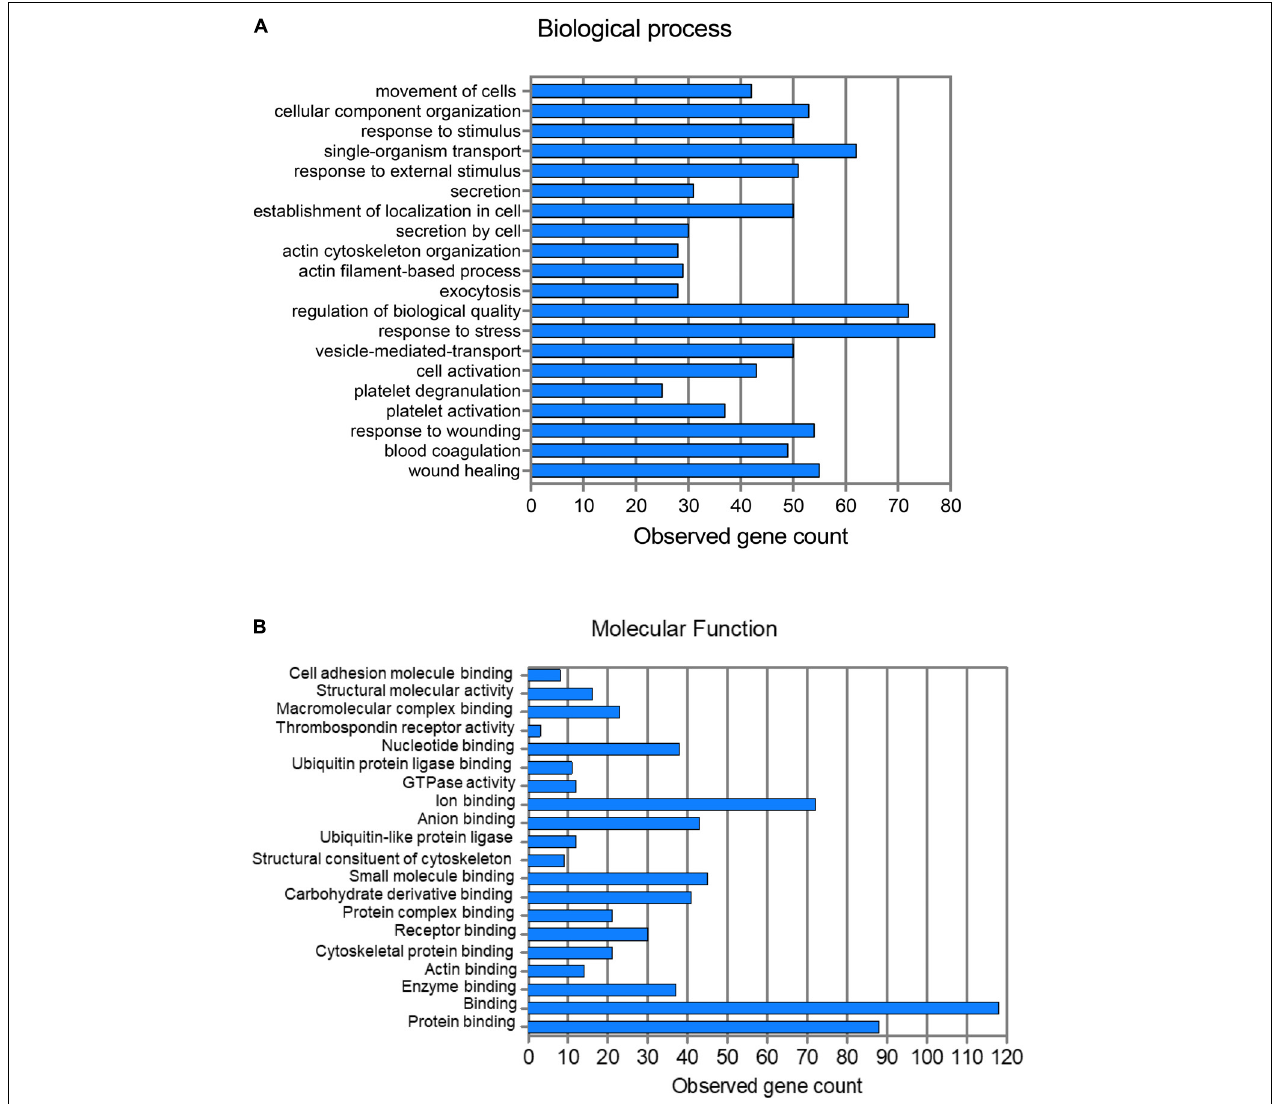
FIGURE 3 | Pathway analysis of 214 proteins showing the top 20 biological processes (A) and molecular functions (B) .